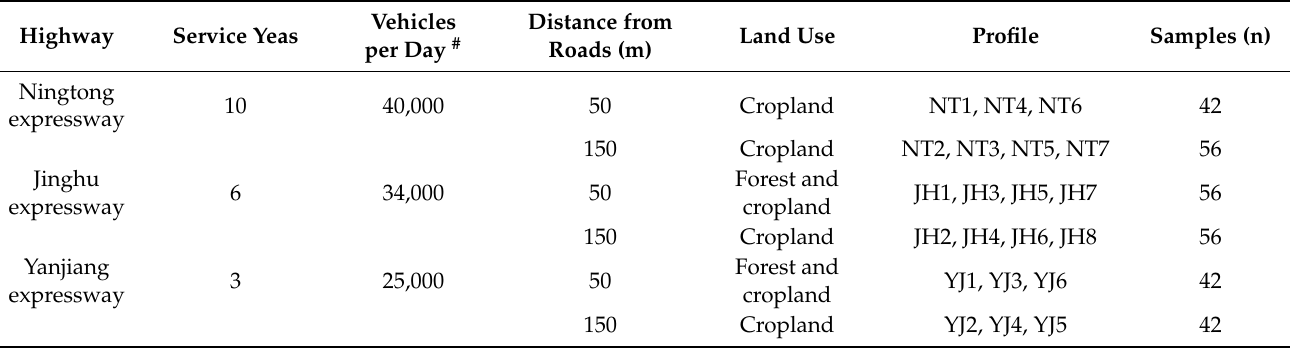
Table 1. Characteristics of studied